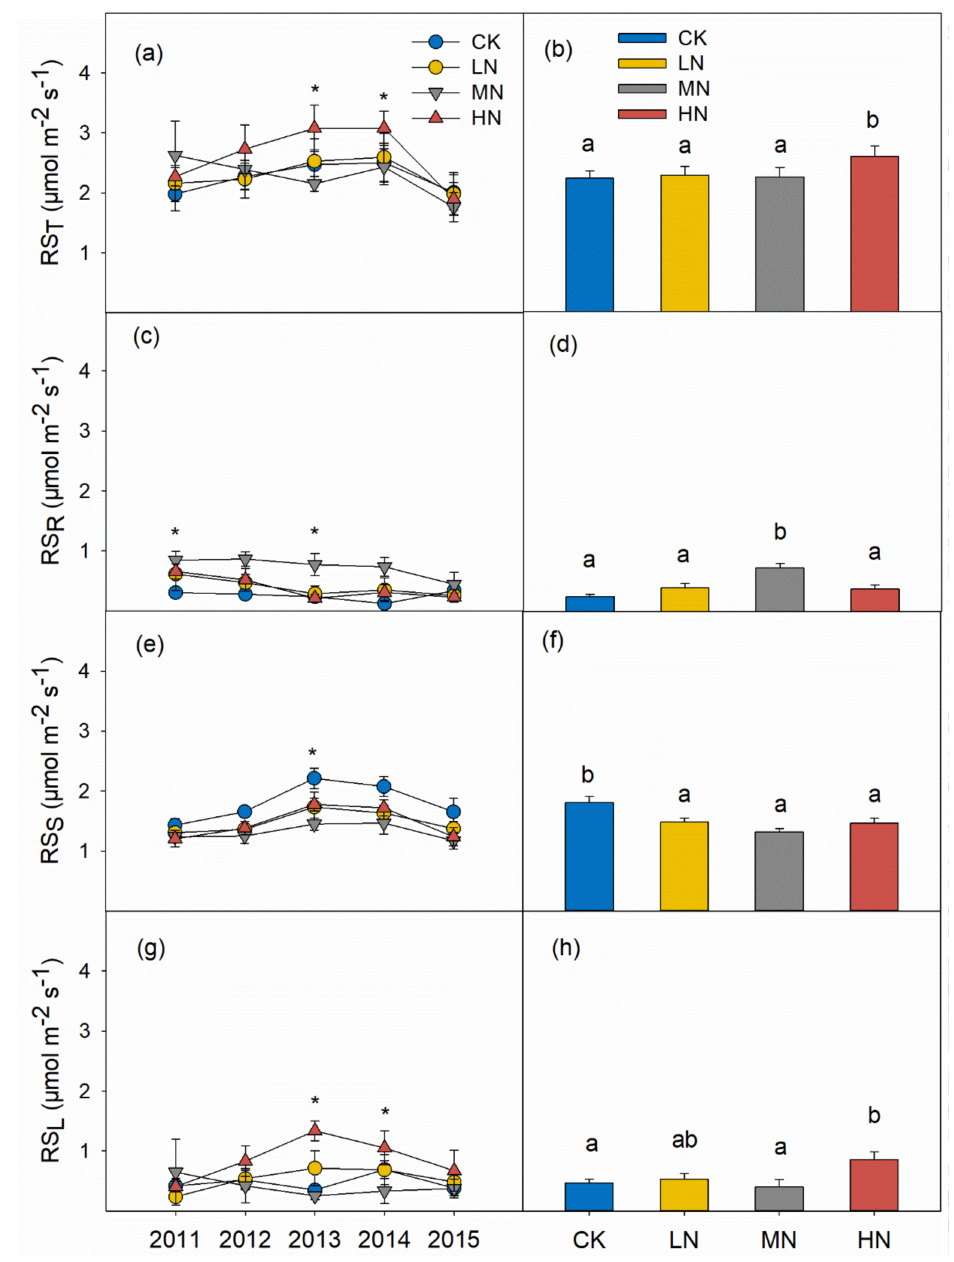
Figure 2. Averaged total soil respiration ( RS T ) ( a , b ), and plant root ( RS R ) ( c , d ), root removal soil ( RS S ) ( e , f ) and litter layer ( RS L ) ( g , h ) from 2011 to 2015 in the planted forest of Chinese pine. The histograms represent the average values over the five years. CK, LN, MN and HN represent control, low N, medium N and high N treatment, respectively. A star on the top of bars represents significant differences ( p < 0.05). Different letters represent significant difference between N addition treatments ( p < 0.05). Data are mean ±